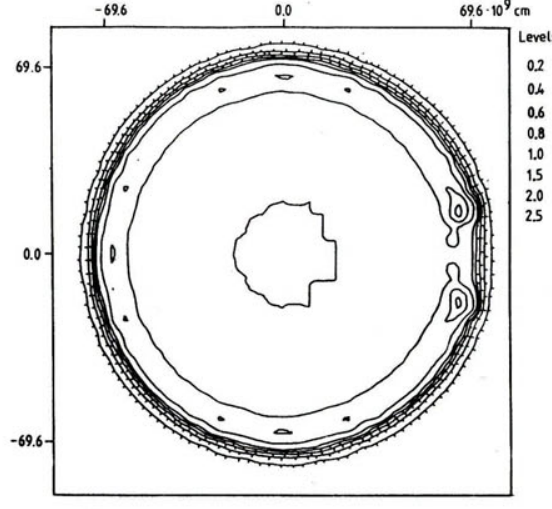
Fig. 7. Radio brightness of the quiet Sun with a coronal hole simu- lated at the wavelength 31.6 cm.